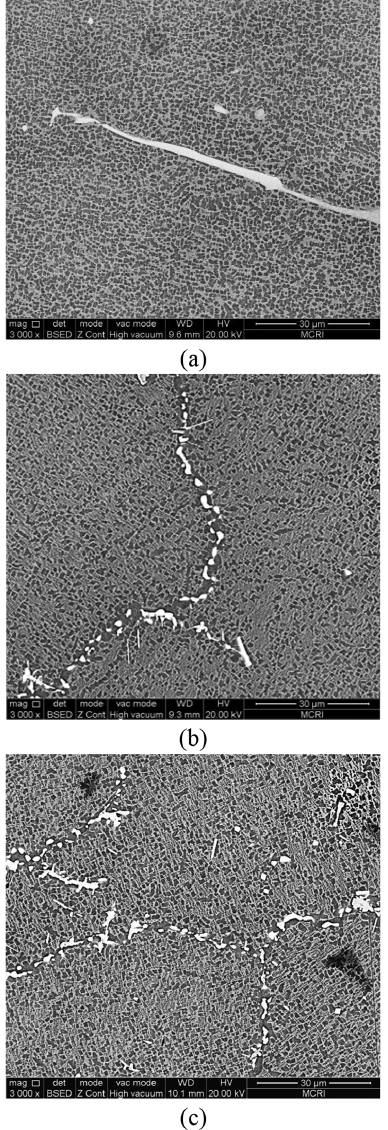
Figure 2: The grain morphology in non-HIPed and HIPed K403 superalloy: (a) Cas; (b) H35 and (c) H45.